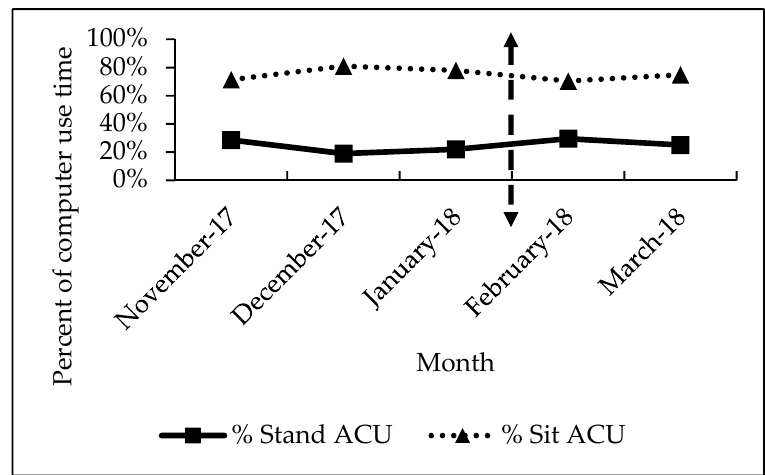
Figure 5. The time desks were in sitting and standing position as a percent of computer use. Dashed line with two arrows indicates the beginning of the intervention.